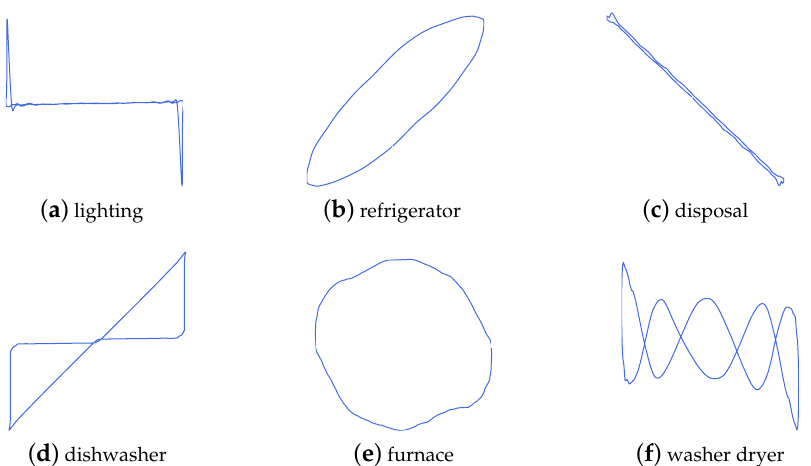
Figure 3. The V-I trajectories for different appliances from REDD database (taking 6 trajectories as examples).